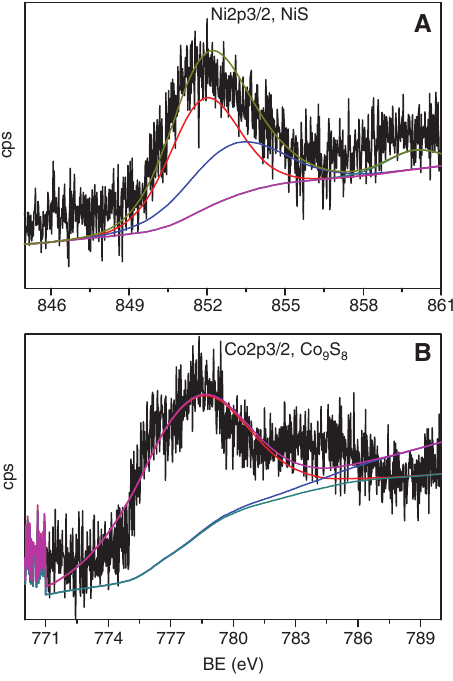
nanospheres and 2